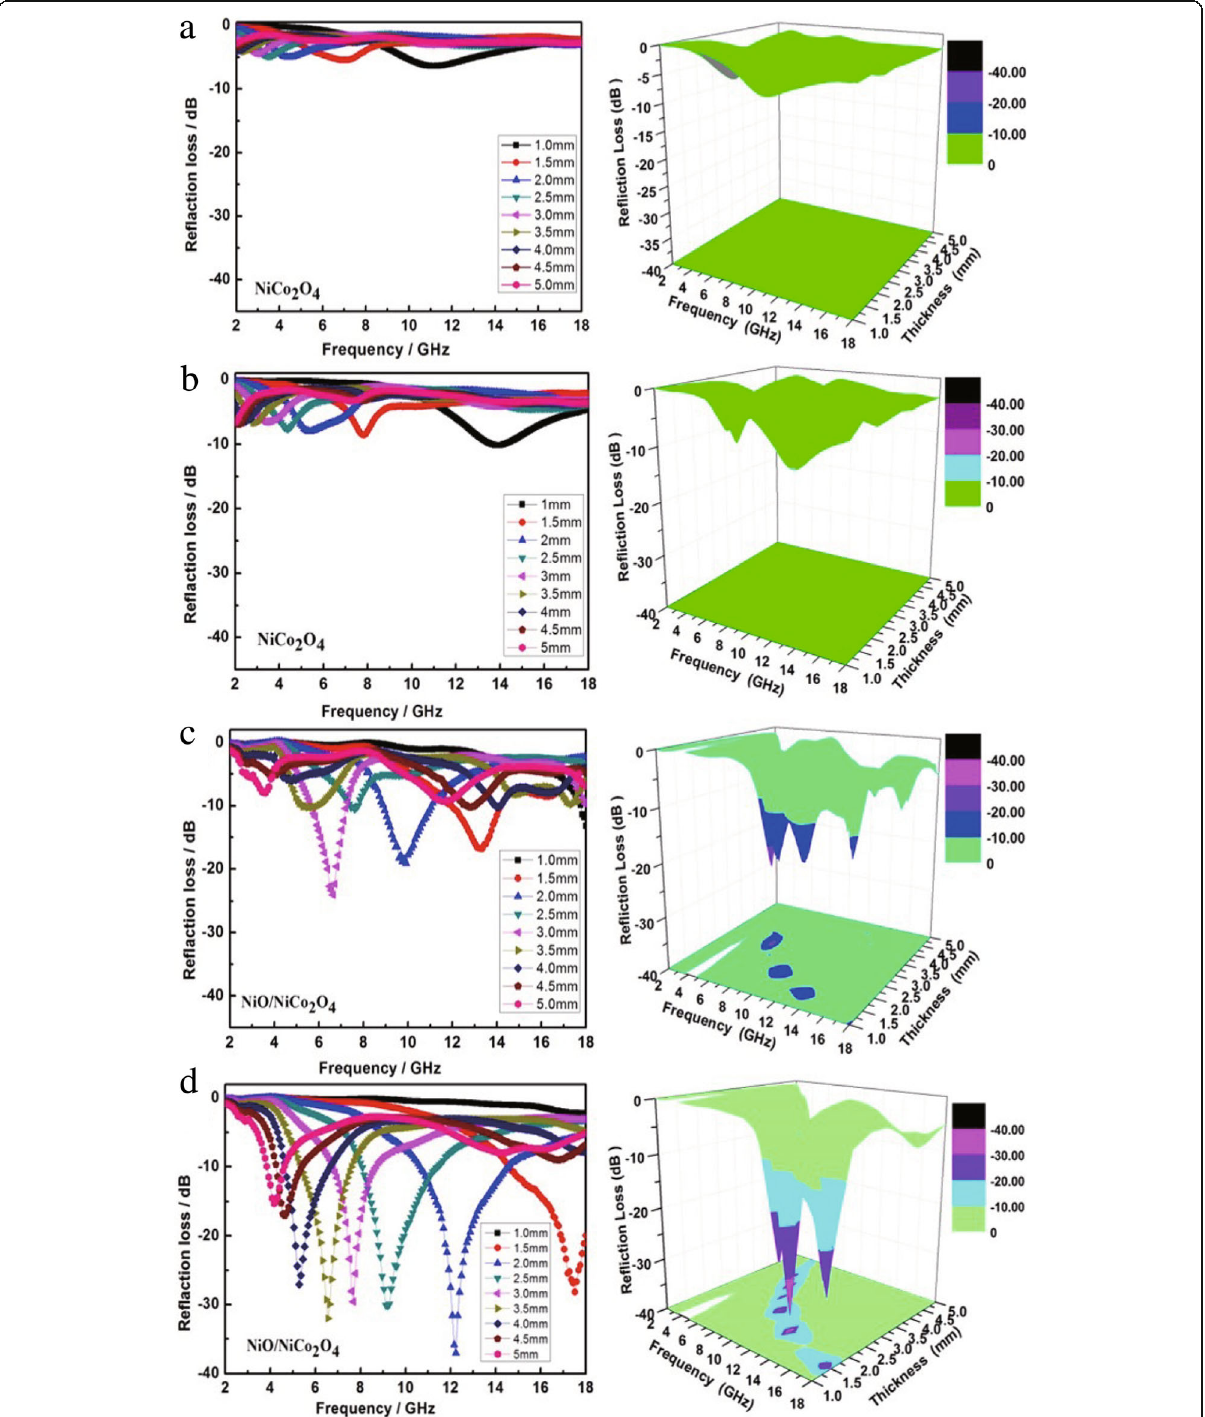
Fig. 5 EM reflection loss curves of the samples. Where a – d represent the reflection loss curves of the samples with the annealing temperatures of 350 °C, 450 °C, 550 °C and 650 °C, and the images on the right correspond to the 3D reflection losses of the samples,